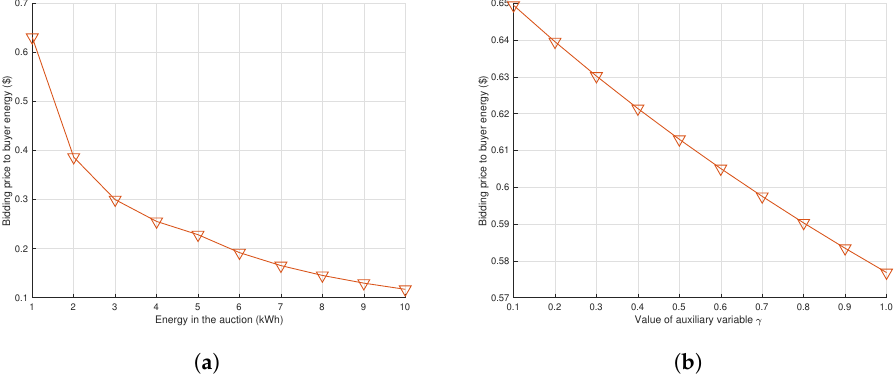
Figure 12. Determination of bidding cost of buyer i according to environmental changes. ( a ) Com- pared with static system; ( b ) Compared with static